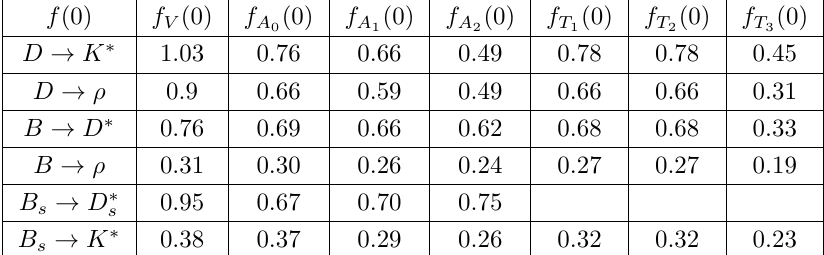
Table 13 . Part I: Best-(cid:12)t parameters values for eqs. (C.8){(C.9) from refs. [63, 129].